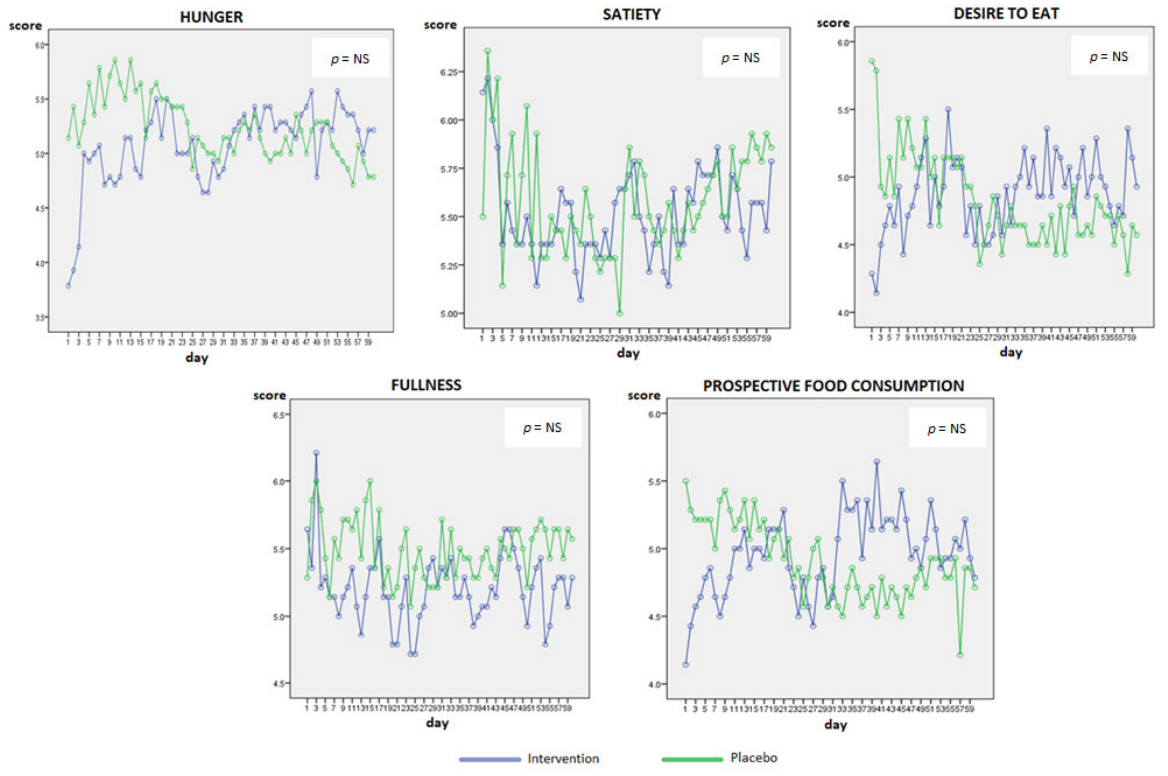
Figure 3. Graphical representation of Eating Motivation VAS changes in groups during 60 days.